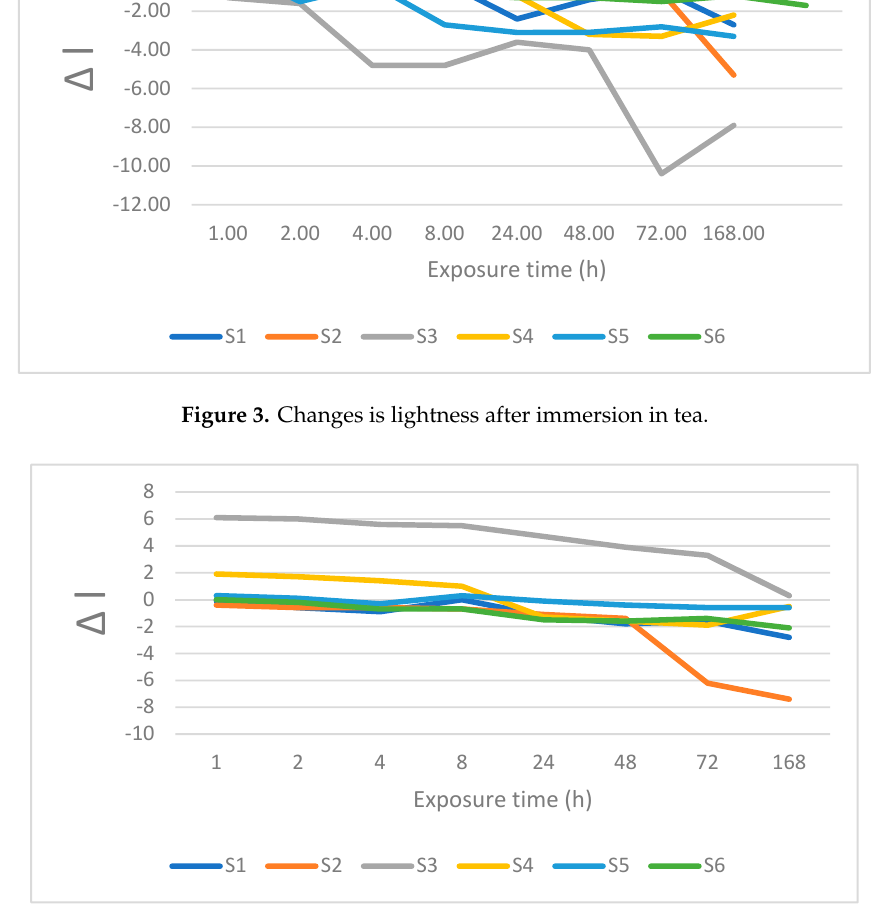
Figure 4. Changes is lightness after immersion in coffee.